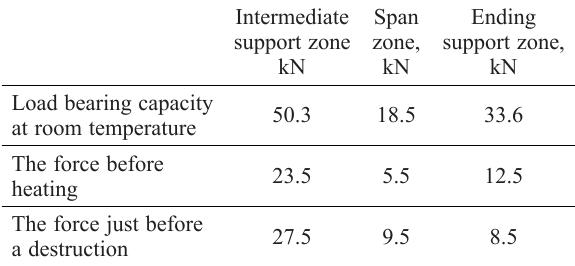
Table 2. Comparison of calculated shear load bearing capacity and shear forces occurred in tested beams Intermediate support